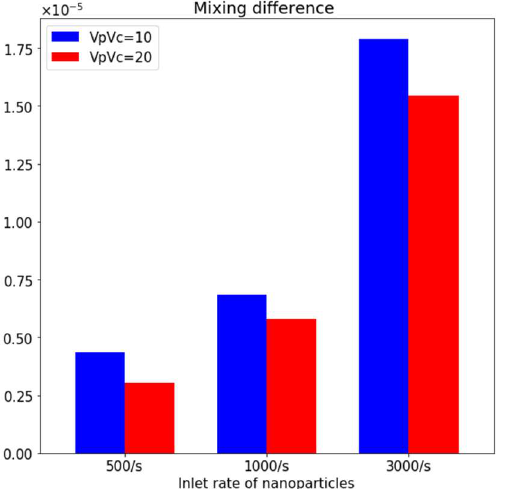
Figure 7. Mixing differences between different diameters of nanoparticles under inlet velocity ratios V p /V c = 10 and V p /V c = 20 and inlet rates equal to 500, 1000, and 3000 nanoparticles per second.